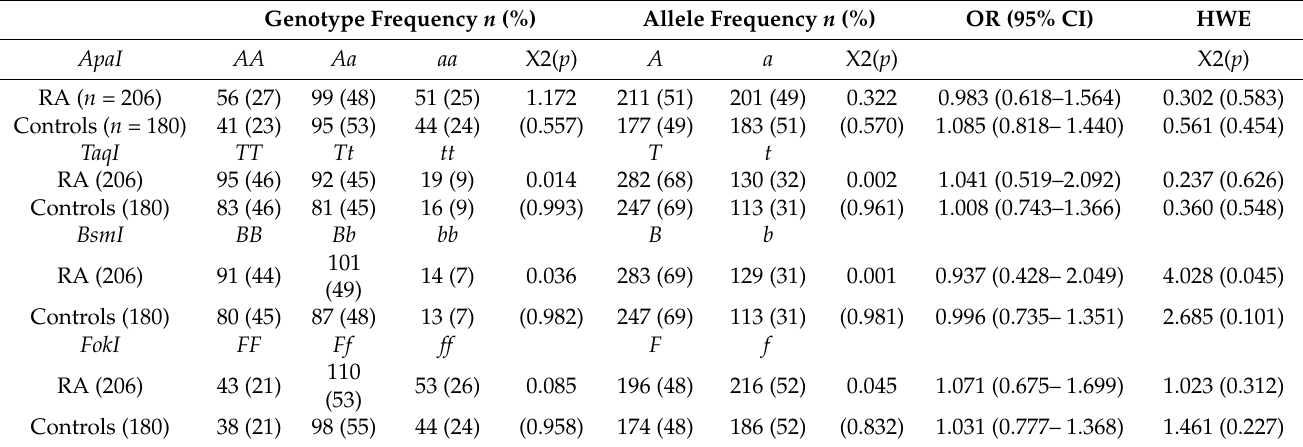
Table 2. Vitamin D receptor ( VDR ) gene genotype and allele frequency distribution in RA and controls. Genotype Frequency n